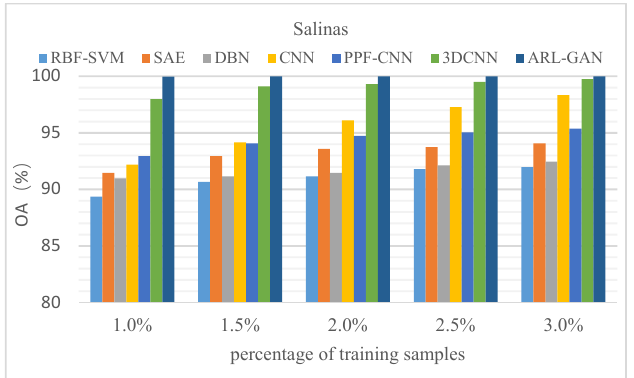
Figure 9. Accuracy of seven classification algorithms for the Salinas dataset under different numbers of training samples.